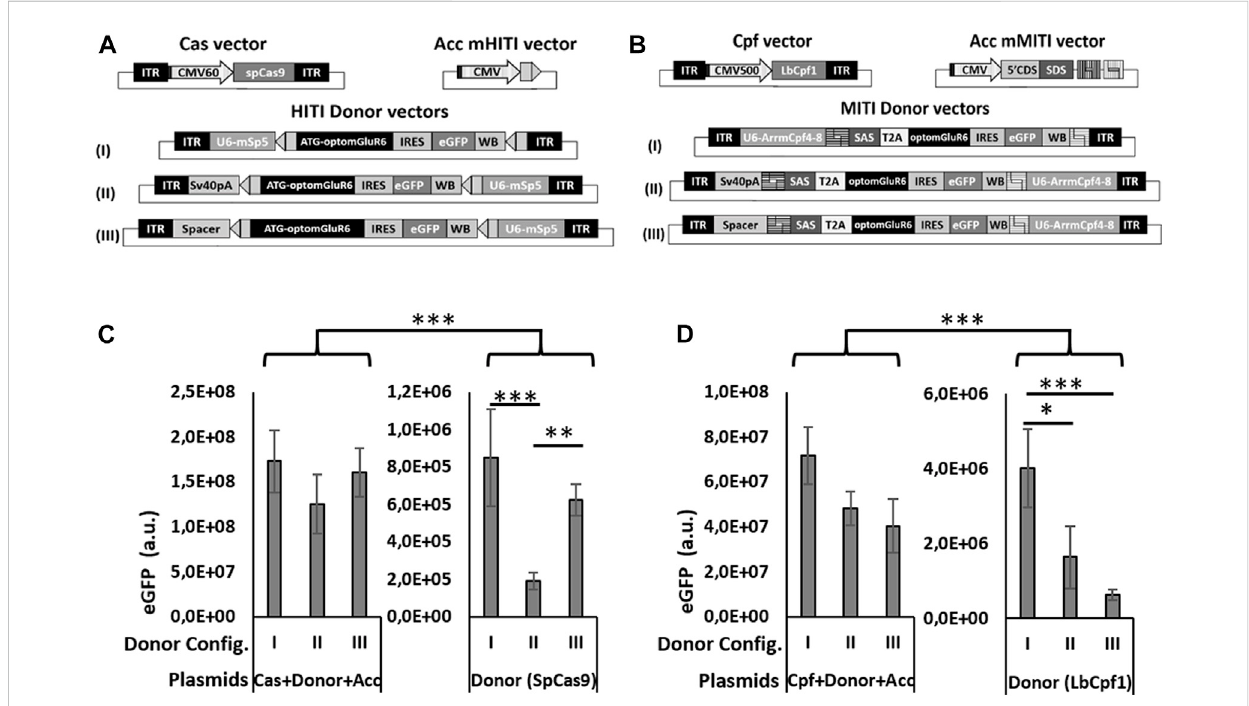
FIGURE 2 Different con fi gurations of donor vectors show different ef fi ciencies in HITI/MITI and different background expression. (A, B) Schematic representation of the set of vectors for HITI (A) and MITI (B) with murine sgRNAs and (C, D) quanti fi cation of eGFP expression (number of